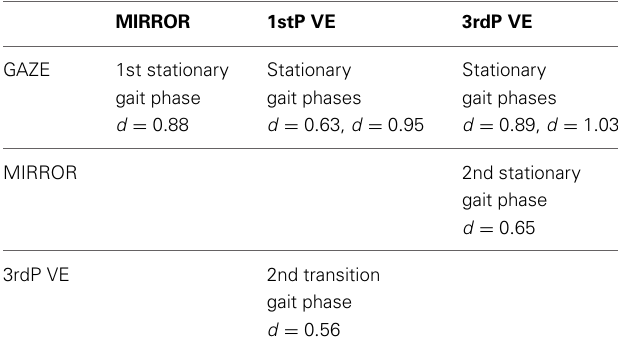
Table 4 | Significant differences in single gait phase spectra between feedback conditions ( p ≤ 0 . 0085) and cohen’s d values for Cluster